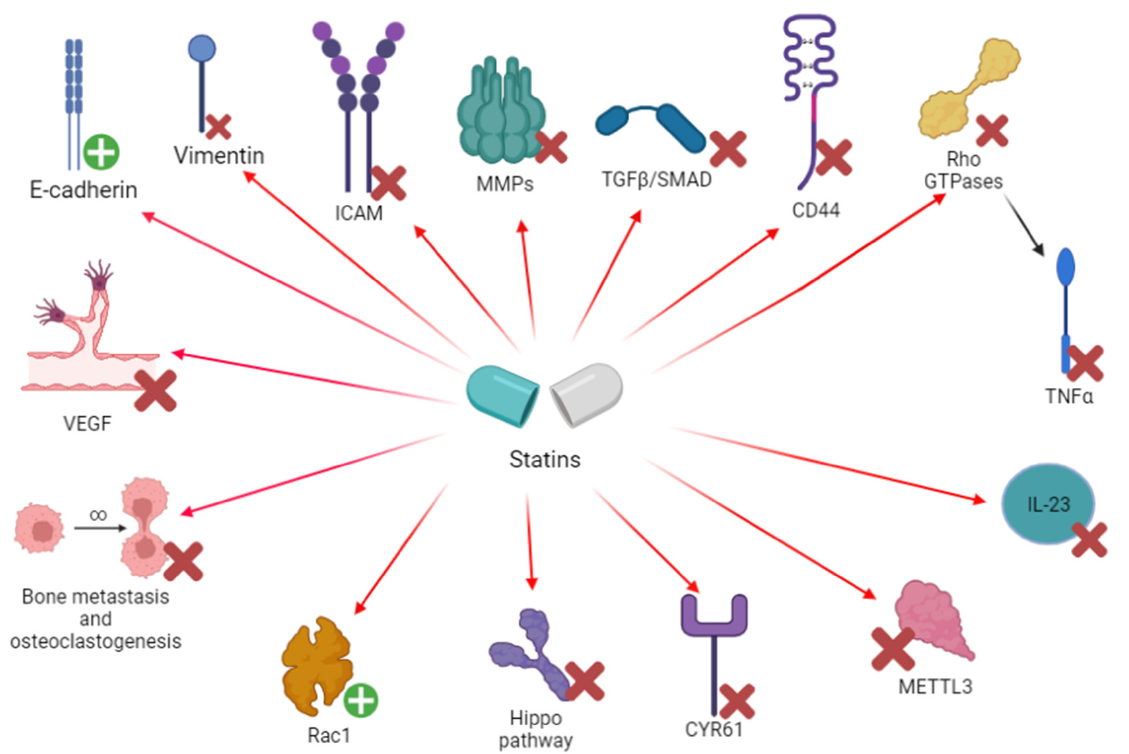
Figure 2. Schematic representation of the effects of statins on both protein (and receptors) and cells involved in angiogenesis and metastasis. CD, cluster of differentiation; CYR61, cysteine-rich angiogenic inducer 61; GTP, guanosine triphosphate; ICAM, intercellular adhesion molecule; IL, interleukin; METTL3, methyltransferase 3; MMP, metalloproteinase; Rac, ras-related C3 botulinum toxin substrate; Rho, ras homologous protein; SMAD: small mother against decapentaplegic; TGF, transforming growth factor; TNF, tumor necrosis factor; VEGF: vascular endothelial growth factor. In an in vitro (A459 cells)/in vivo (murine model) study by Liu et al. [29], simvastatin determined a reduction of CD44, MMP2 and MMP9 ( p < 0.01). Simvastatin inhibited tumor growth and invasion through MAPK/ERK inhibition. Simvastatin and rosuvastatin reduced MMP2 and MMP9 ( p < 0.01) expression in lung cancer tissue samples collected from 12 patients undergoing surgery; MMPs concentration is regulated by NF κ B and its expression is also reduced by statins in normal lung tissue, whereas action on MMPs